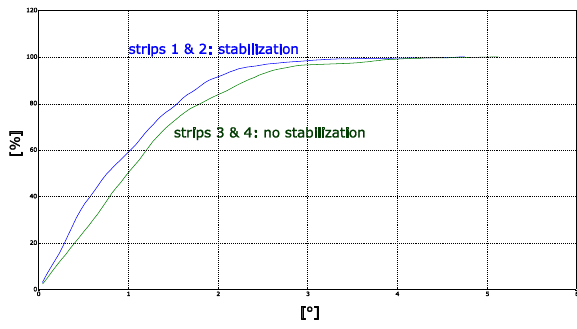
Figure 11. Empirical cumulative distribution function for roll values. Flight #2.